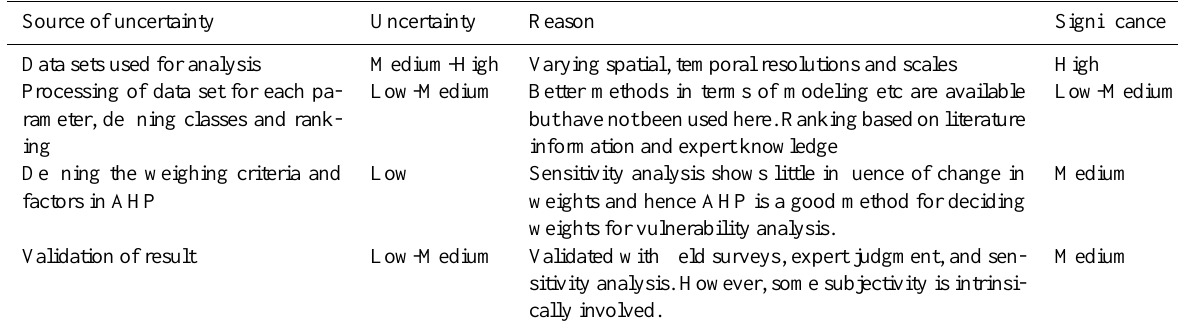
Table 11. Qualitative estimation of uncertainties within the case study. Source of